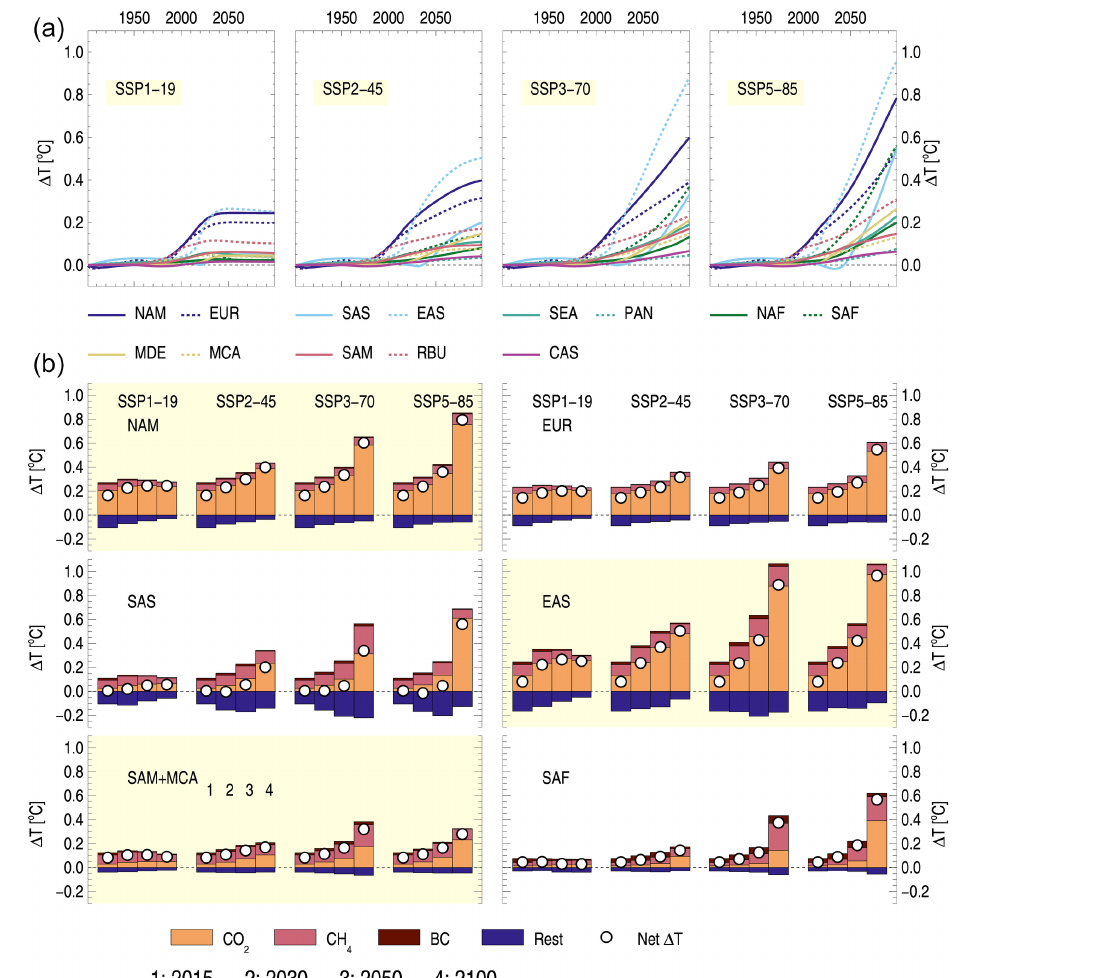
Figure 4. Global mean temperature response to historical emissions and future SSP pathways: (a) net (i.e., sum over all species and sectors) response over the period 1900 to 2100 for each region and scenario and (b) net response in 2015, 2030, 2050 and 2100 to emissions in six regions broken down by contributions from CO 2 ; BC; methane; and the sum of SO 2 , OC, NH 3 , and ozone precursors (i.e., “rest”).